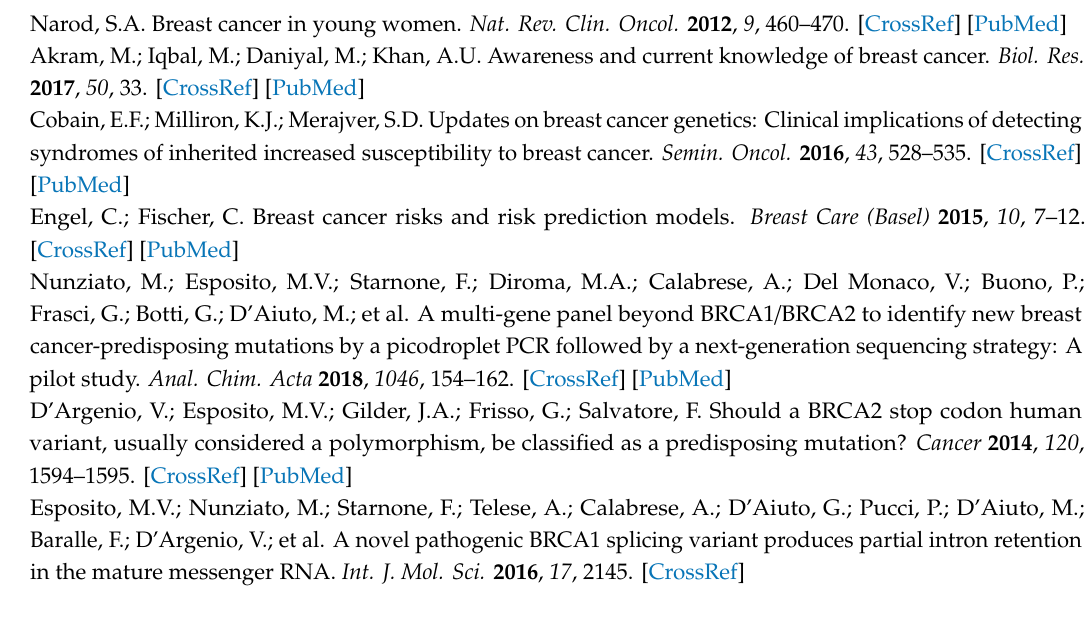
Figure S1: shows the bioinformatics predictions of the p.P2767S variant pathogenicity, performed with some of the software described in our paper. These predictions investigated the role of the p.P2767S variant on the protein structure and amino acidic residue conservation between species, Figure S2: reports the Sanger sequencing results of mutagenesis reactions performed on each BRCA2-CT plasmid before transfection reactions to ensure the production of the desired mutated BRCA2-CT proteins, Figure S3: shows the western blot results of all the BRCA2-CT control proteins derived from a validation set of variants reported in Guidugli et al. [34]. In these experiments, all BRCA2-CT CTRs showed proper expression in NIH-3T3 cells, Figure S4: report the in vitro ssDNA binding assay results comparing samples with and without irradiation: in panel A, the non-transfected non-treated (NT) cells compared to the non-transfected irradiated (IR) cells are shown; panel B shows the di ff erences between samples not subjected to irradiation (IR), Figure S5: The dose dependent binding assay of the BRCA2-CT L2688P (A) and the BRCA2-CT K2729N (B) samples, in which the ssDNA-binding assay was performed using an increasing amount of the nuclear extract, Figure S6: The e ff ect of the endogenous BRCA2 silencing assessed by the in vitro ssDNA-binding assay on silenced and non-silenced samples. The RNAi results were evaluated by quantitative real-time PCR (qPCR) and western blot analysis, Figure S7: Figure 3C: Western blot analysis of the expression of and B: Western Blot analysis of all BRCA2-CT minigenes for validation set analysis, Figure S9: Figure S6 B: The RNAi results evaluated by Western Blot analysis 48 hours after transfection, Table S1: lists the sequence of primers used for cloning (a and b) and the linear 100-mer Cy5-labelled φ X174 single-stranded DNA (c) for the in vitro ssDNA binding reactions, Table S2: shows the sequence of primers used for qPCR